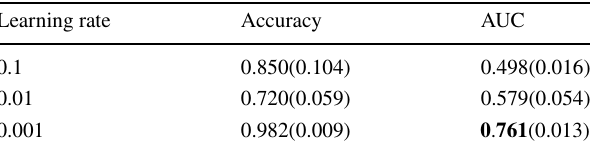
Table 8 The results of different numbers of dilation layers in Wavenet (TEXT) in DMDP with LSTM (FIN) + Wavenet (TEXT)